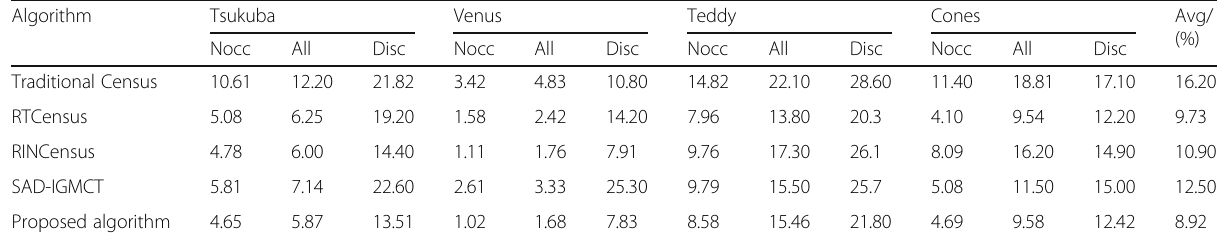
Table 1 The performance comparison between this algorithm and some common local algorithms